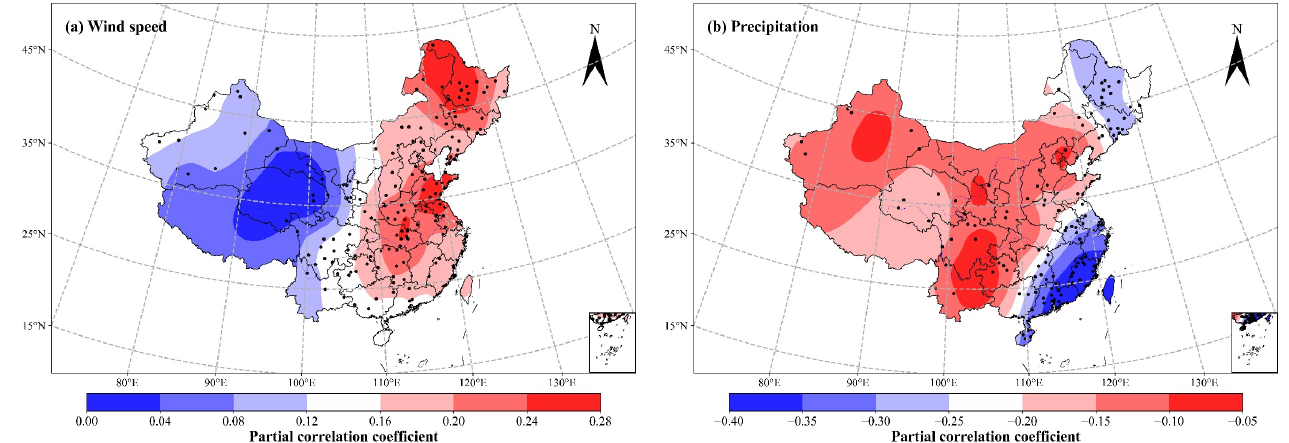
Figure 8. Partial correlation coefficient of SD with wind speed ( a ) and precipitation ( b ) (• indicates sites that passed the p < 0.05 significance test).